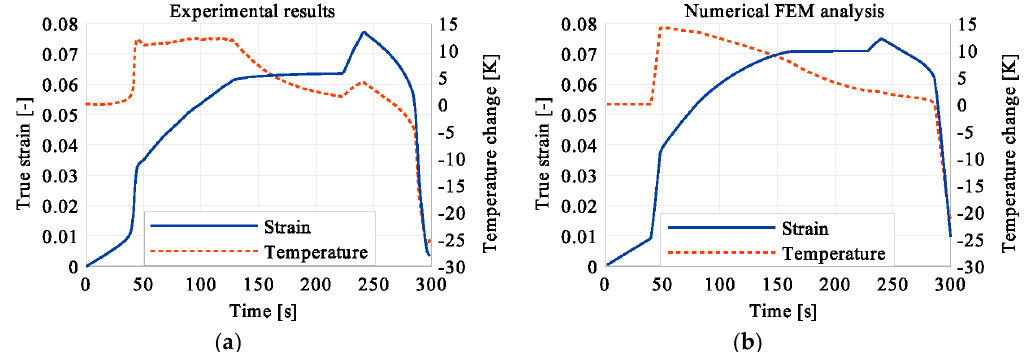
Figure 12. Stress and temperature variations vs. time for the loading program (3): 3-min loading interruption at the end of the LMT: ( a ) experimental; ( b ) numerical results.